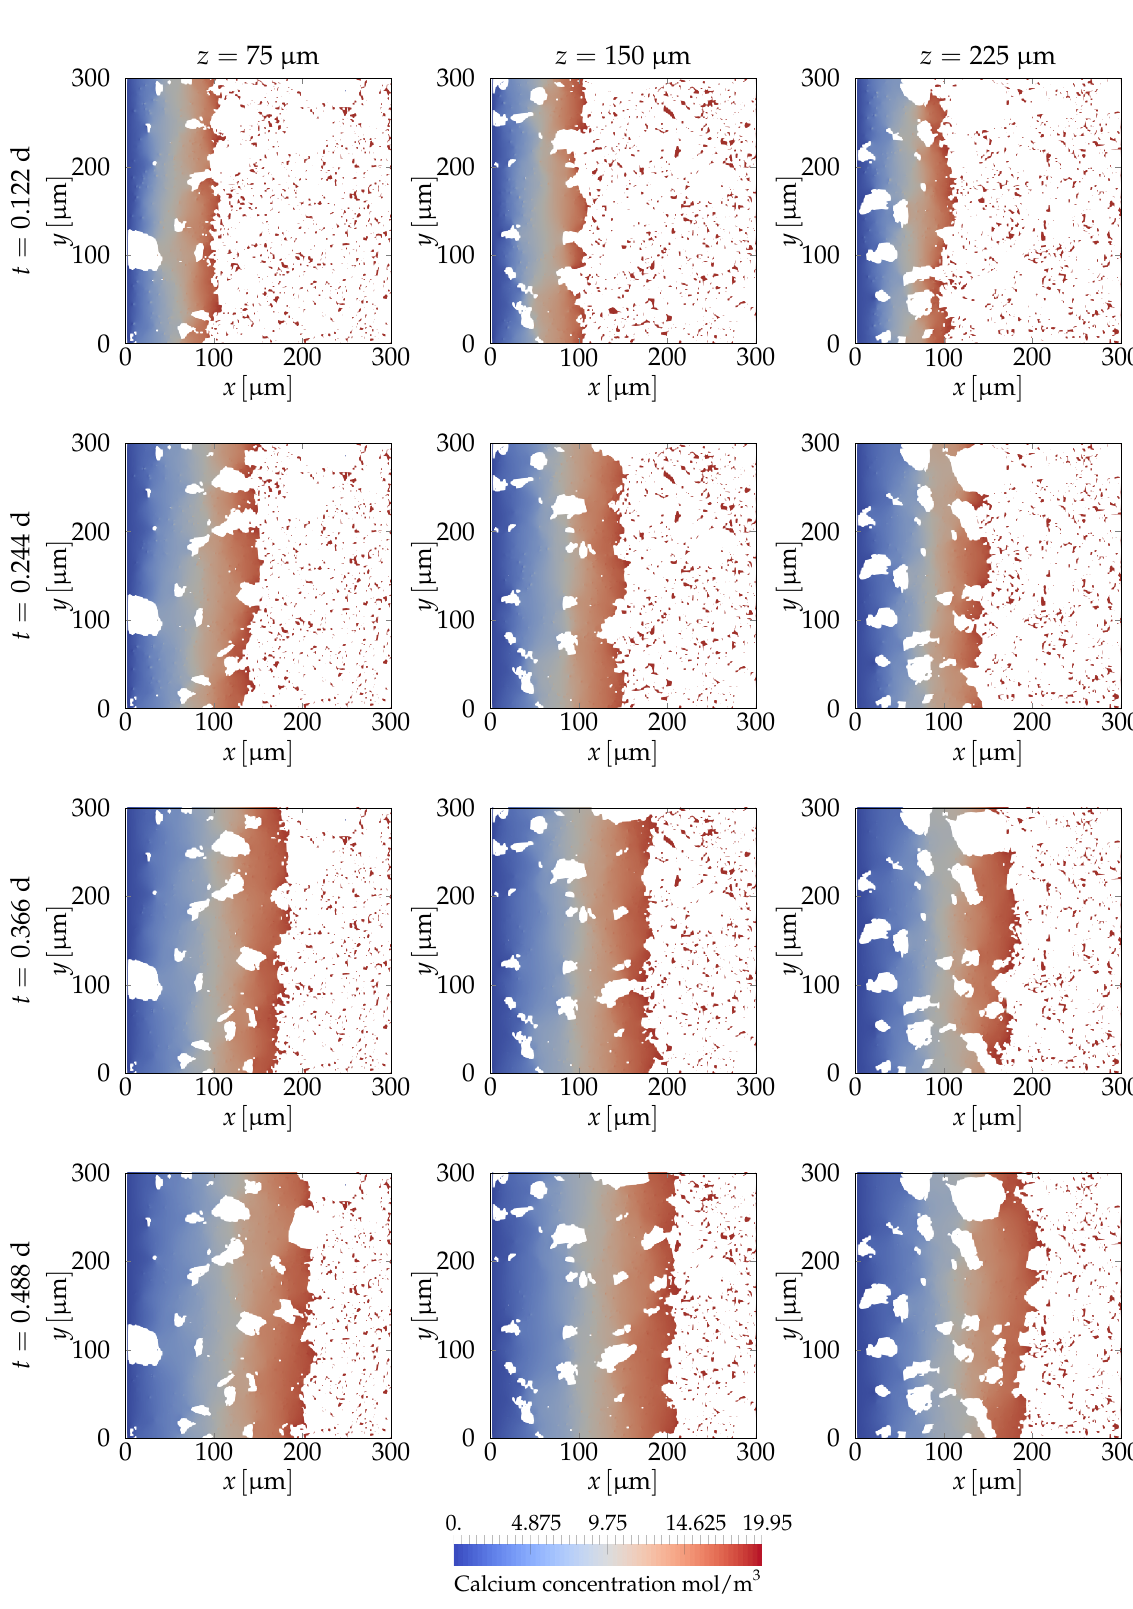
Figure 11. Slices of the dissolution process shown in Figure 10. The columns present slices at planes z The rows of the above figure show the evolution with time of the calcium leaching front. The white regions in the dissolute zone are the locations of the unhydrated